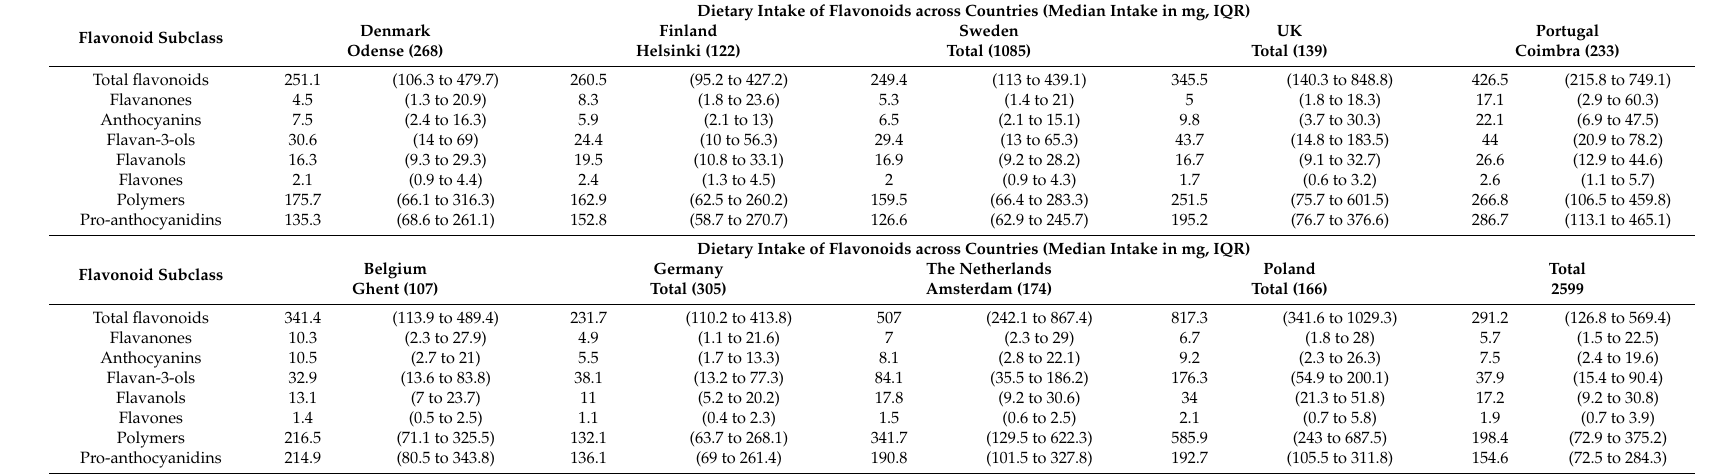
Table 2. Dietary intake of main flavonoid subclasses in adults from countries participating in GA 2 LEN.